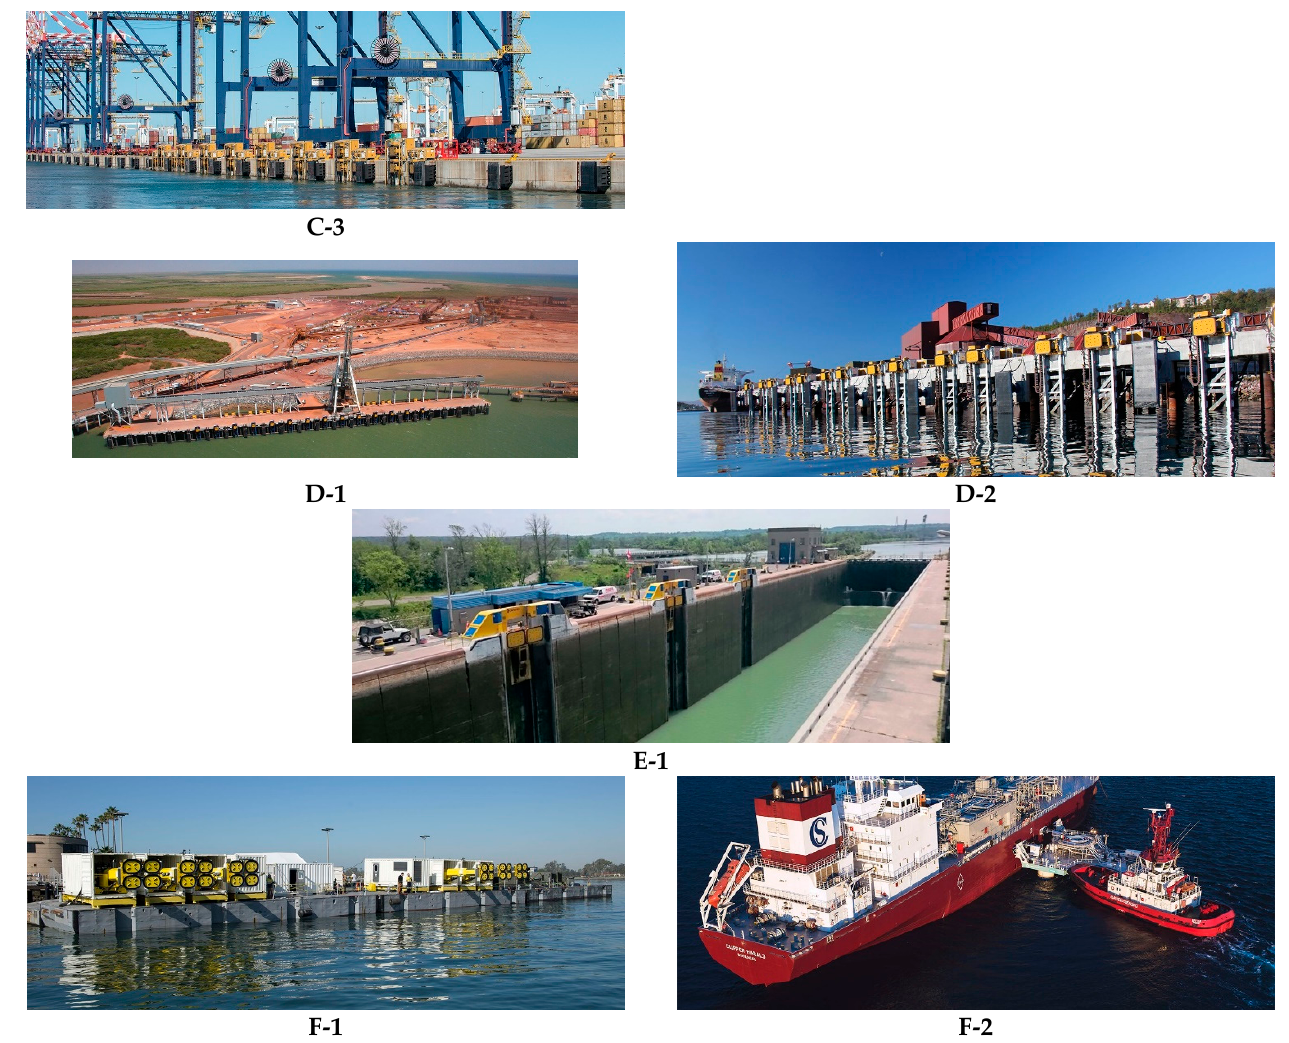
Figure A1. Application of shore-based system of automated vacuum mooring showing, application of RoPax and RoRo on ( A-1 ) Port of Helsinki, Finland, ( A-2 ) Wightlink, UK, ( A-3 ) Searoad, Aus- tralia, ( A-4 ) Samsø Rederi, Denmark, ( A-5 ) Molslinjen, Denmark, ( A-6 ) Interislander, New Zealand, ( A-7 ) Teso, The Netherlands; application of Electric Vessels on ( B-1 ) Norled, Norway,( B-2 ) Asko Maritime, Norway, ( B-3 ) Fjord1, Norway, ( B-4 ) Finferries, Finland, ( B-5 ) Ærø Ferries, Denmark; application of Container on ( C-1 ) Port of Salalah, Oman, ( C-2 ) Port of Beirut, Lebanon, ( C-3 ) Port of Ngqura, South Africa; application of Bulk on ( D-1 ) Port Hedland, Australia, ( D-2 ) Port of Narvik, Nor- way; application of Locks on ( E-1 ) St. Lawrence Seaway, US and Canada; application of Ship-to-ship on ( F-1 ) US Navy, USA, ( F-2 ) Econnect Energy (Connect LNG),